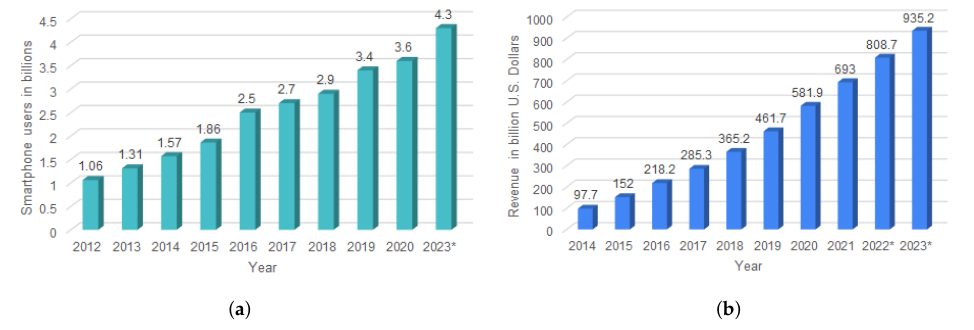
Figure 1. ( a ) available count of smartphone users worldwide [2]; and ( b ) global mobile application market size [1], where * represents the predicted value for 2022 and